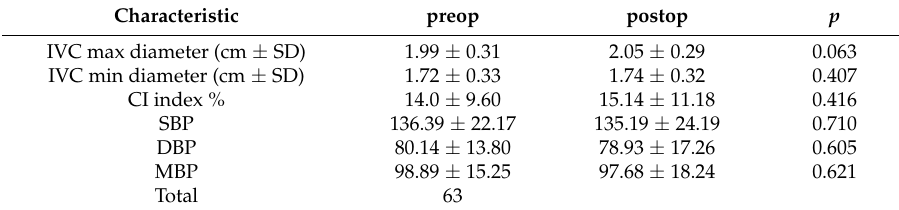
Table 2. Characteristics of inferior vena cava diameters and hemodynamic parameters preoperatively and postoperatively.